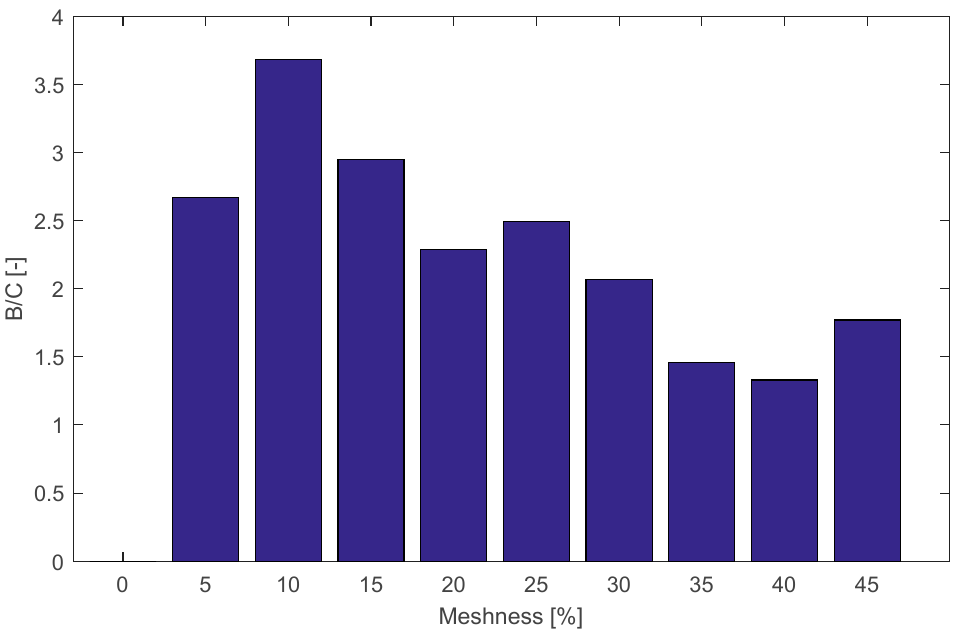
Figure 3. Ratio between benefits (B) and costs (C) for different Meshness degrees. The B/C ratio, however, differs significantly among the different analyzed levels of Meshness. In fact, a maximum value of approximately 3.7 occurs at the 10%